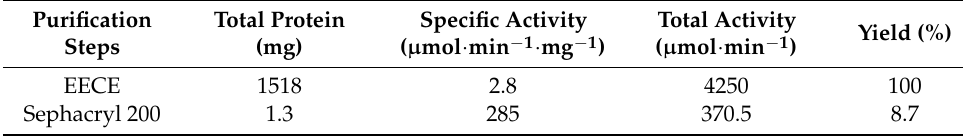
Table 1. Purification of extracellular laccase from A. pediades